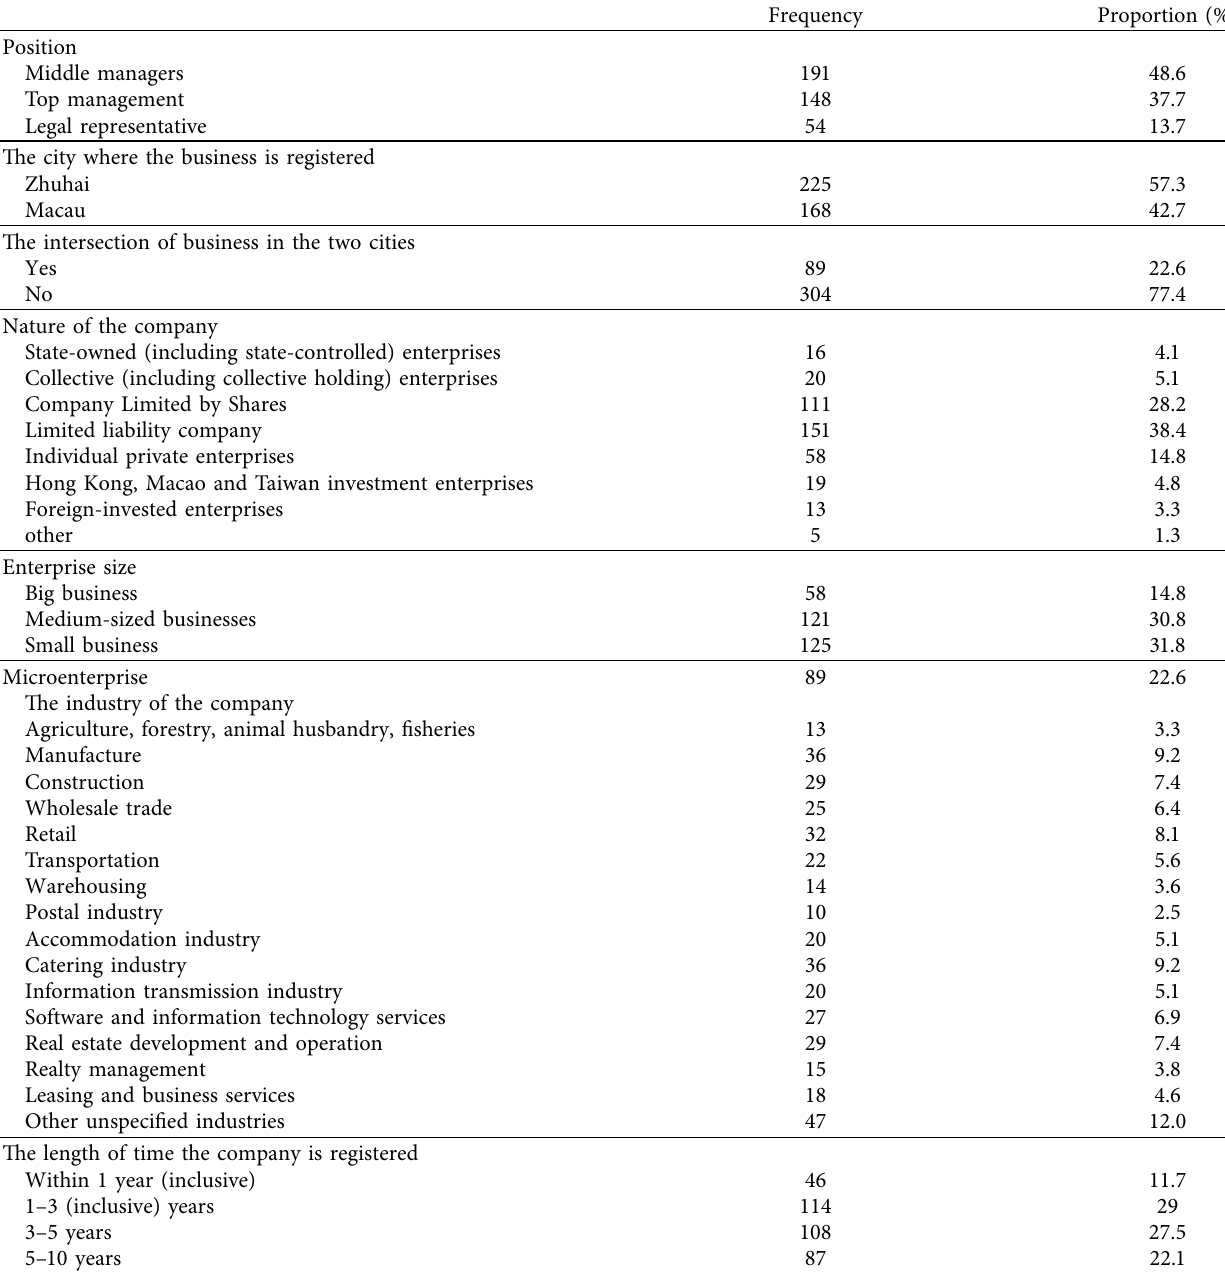
Table 1: Descriptive statistical